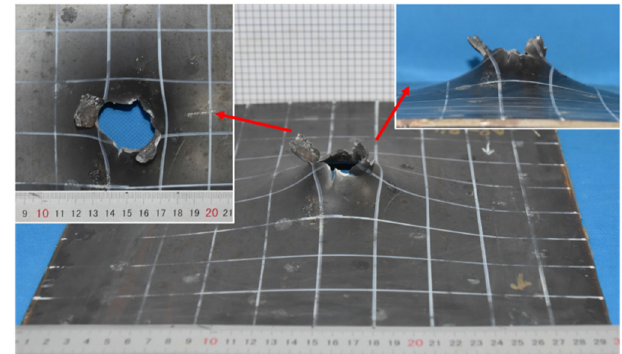
Figure 14. Fracture morphology of back plate in Experiment 3.